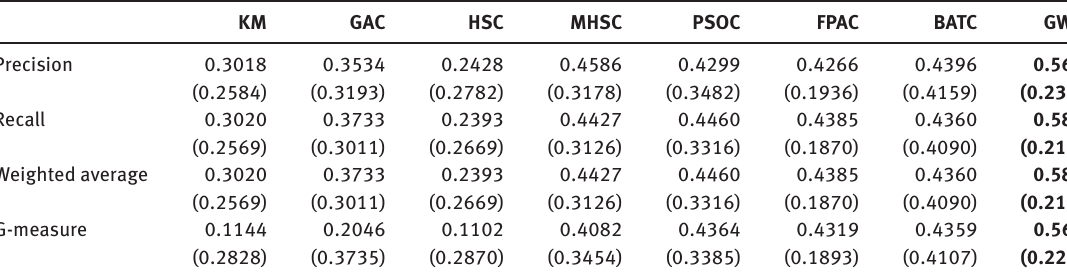
Table 5: Mean (SD) of Cluster Quality Matrices for Iris Data Set.